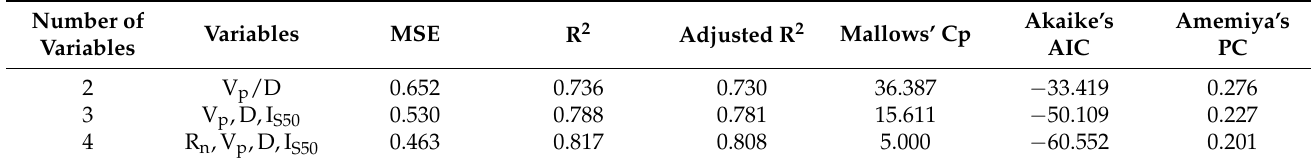
Table 2. Best subset analysis for selecting the optimum input combination.